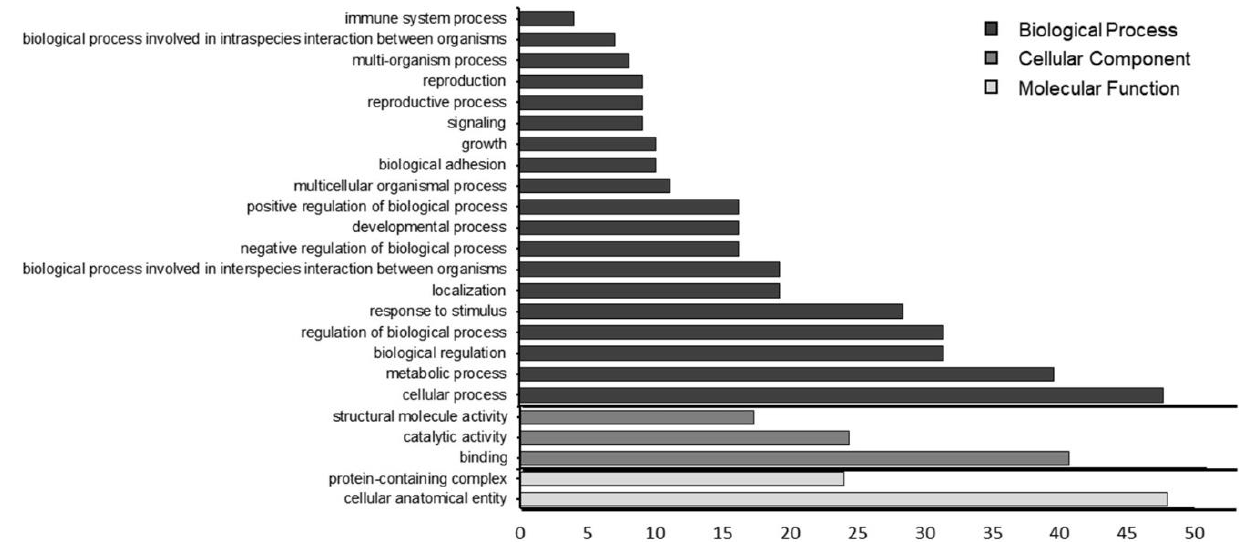
Figure 4. Functional classification of proteins from the pectinase crude extract secreted by S. cerevisiae strain.